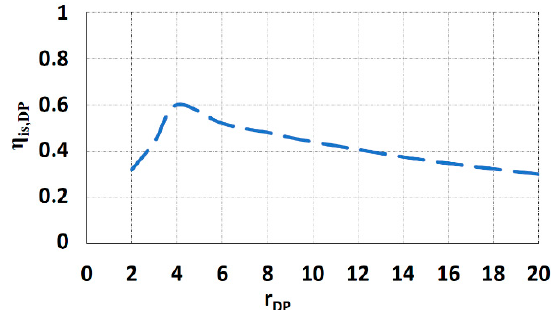
Figure 7. Isentropic efficiency corresponding to the selected design point expansion ratio for scroll expanders.